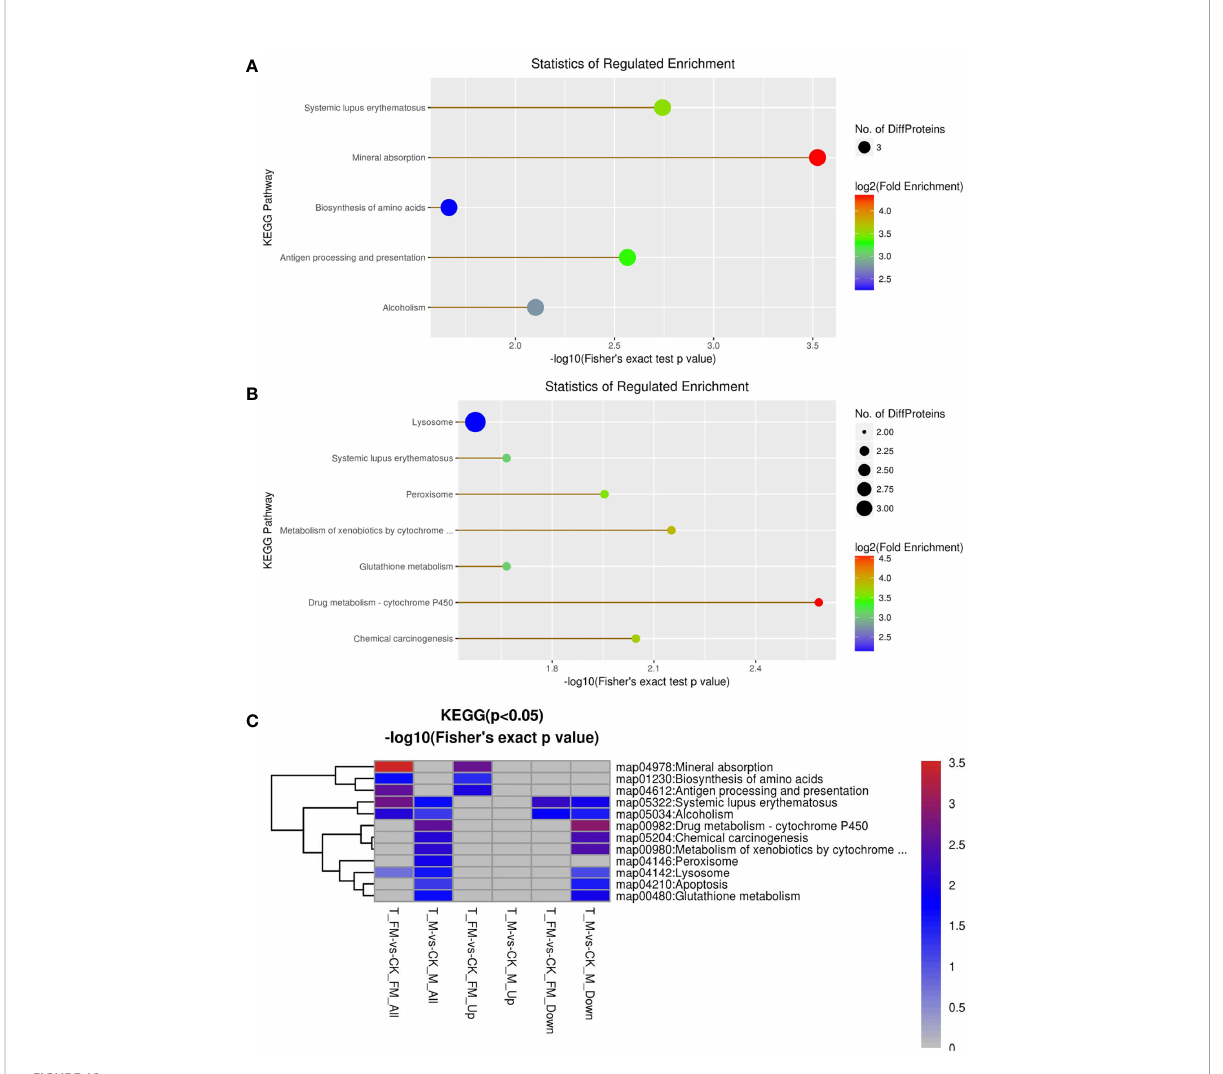
FIGURE 12 GO enrichment analysis for KEGG in female (A) and male (B) adult S. japonicum